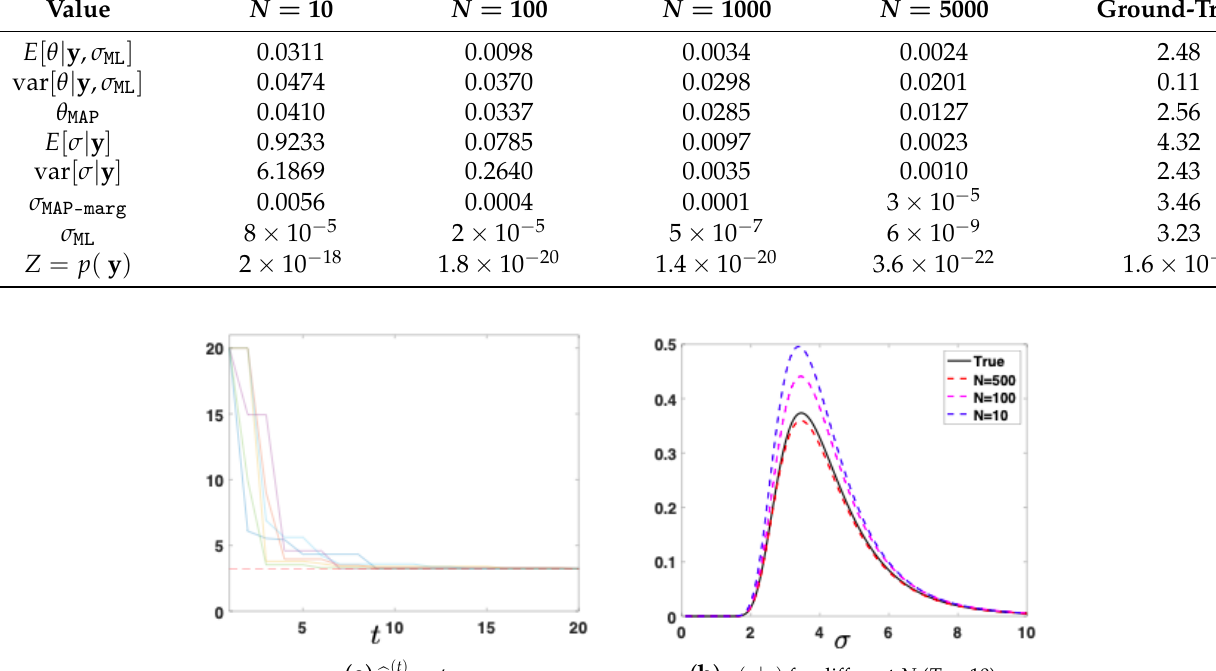
( t ) ML (different runs) versus the number of iterations t , with N